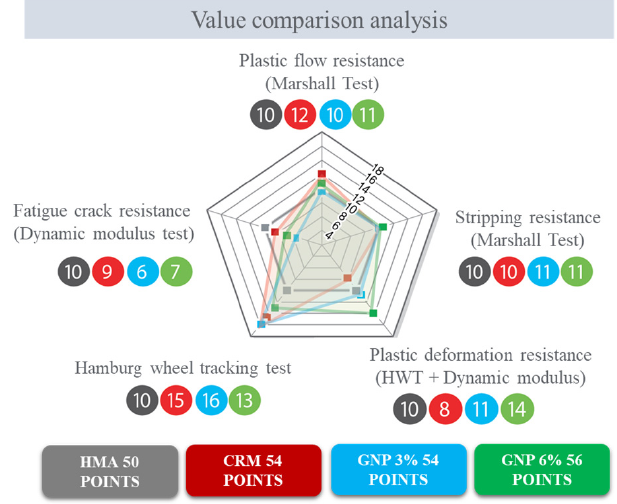
Figure 14. Results of performance evaluation analysis.